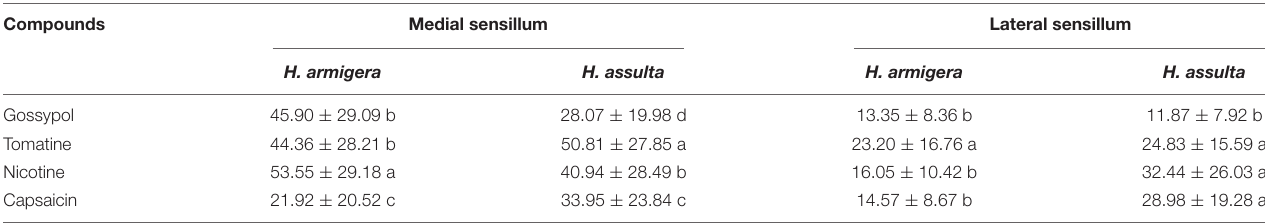
TABLE 3 | Multiple comparisons of gustatory responses of “M2” GRNs in styloconic sensilla of Helicoverpa spp. to different plant secondary metabolites. Compounds Medial sensillum Lateral sensillum H. armigera H. assulta H.